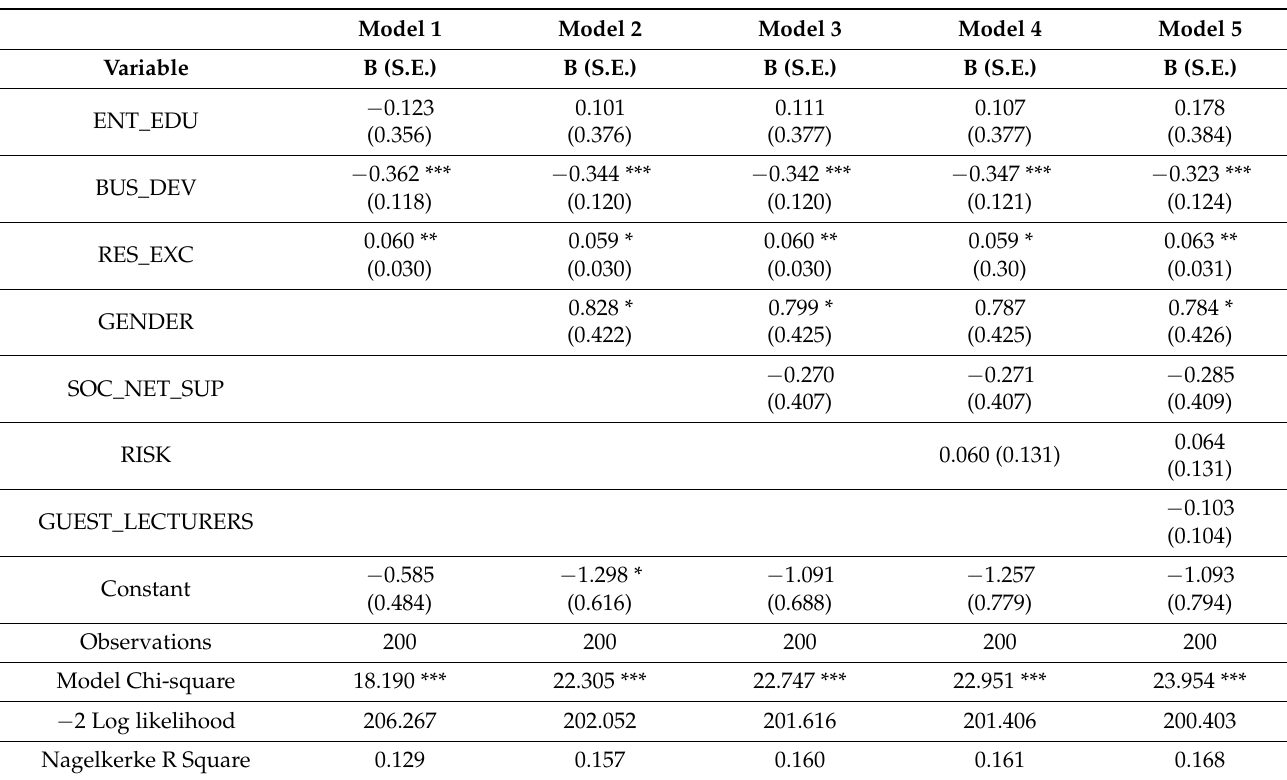
Table 5. Logit regression. Dependent variable: nascent technology